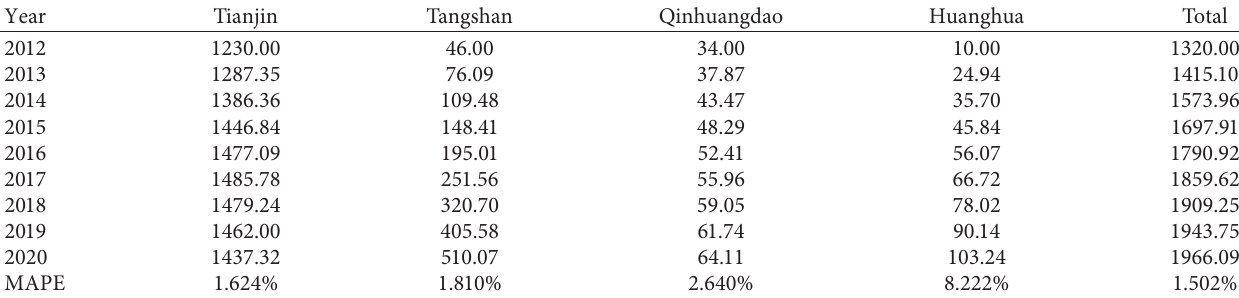
Table 3: FGM (1.1) when r � 0 . 5 container throughput of Tianjin-Hebei Port Group (unit: 10,000TEU).